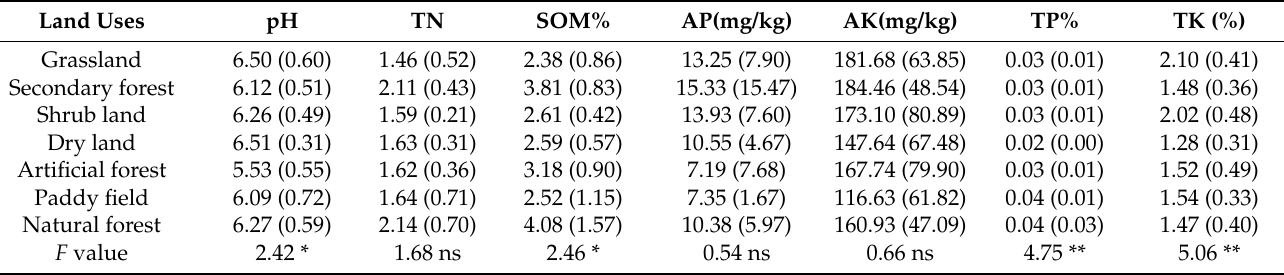
Table 4. Soil properties under different land